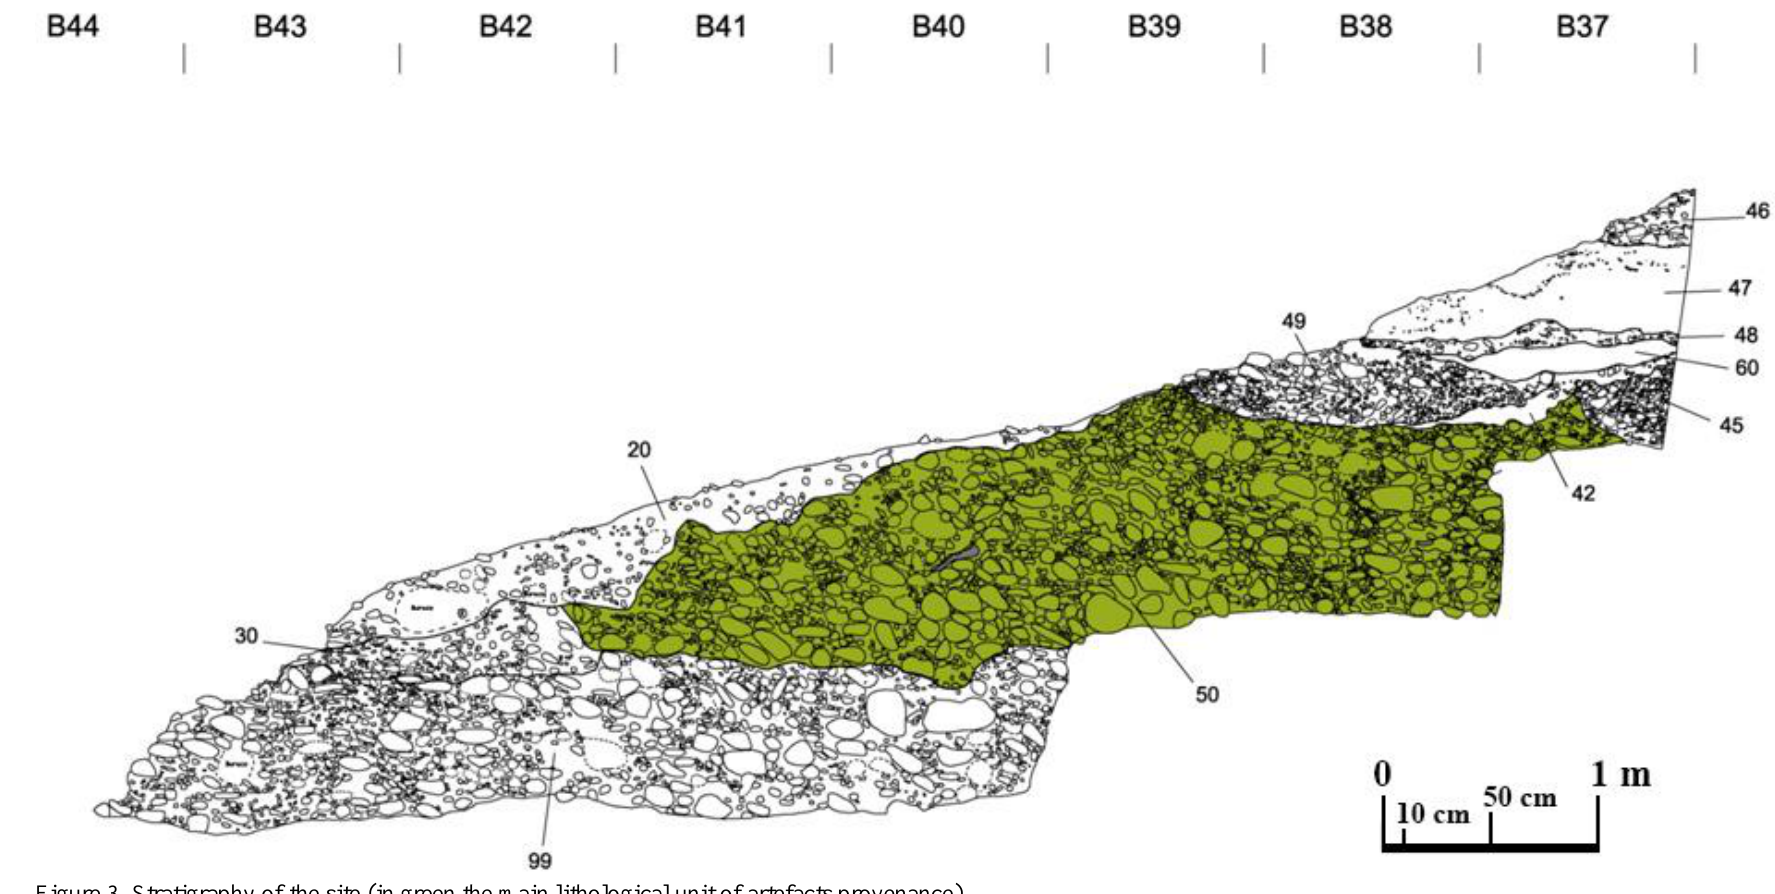
Figure 3. Stratigraphy of the site (in green the main lithological unit of artefacts